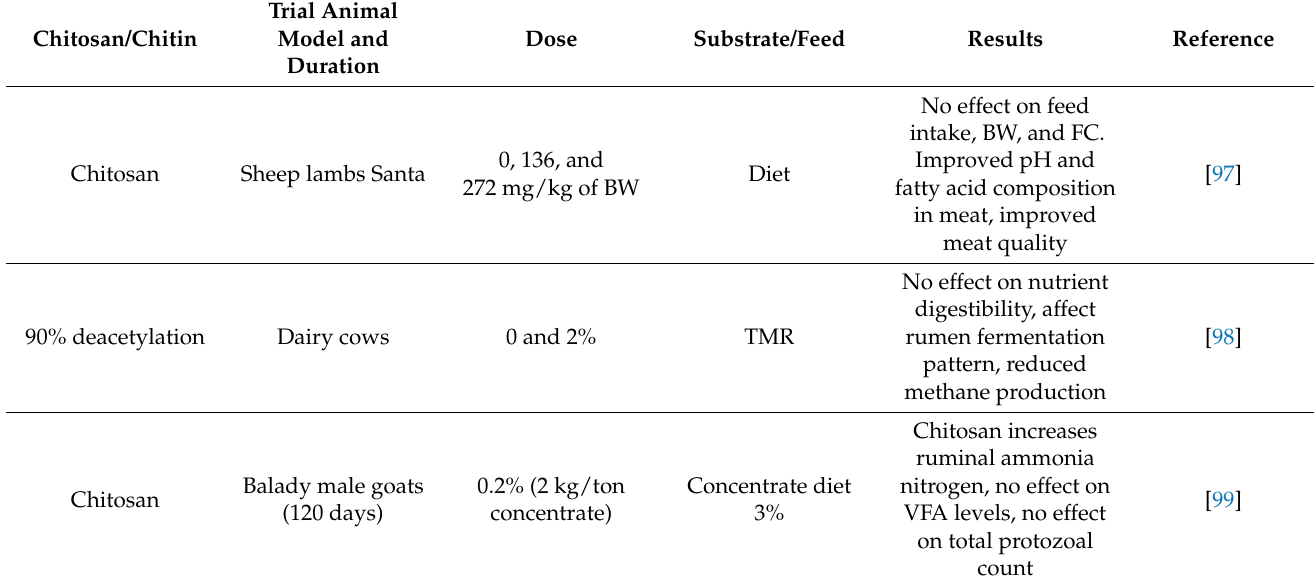
Table 1. Effects of the chitosan/chitin inclusion in diets of ruminants on dry matter intake, digestibil- ity, and rumen